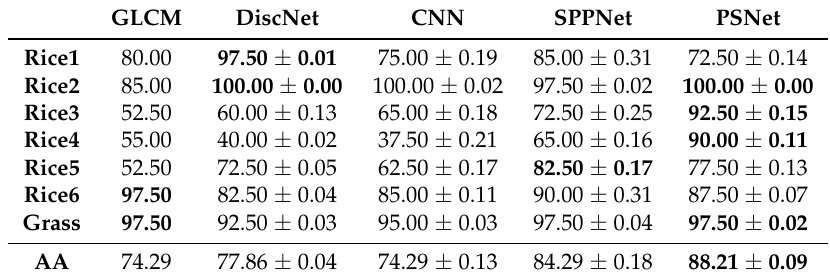
Table 6. Classification accuracy (%) on the Rice dataset. The bold number highlights the greatest classification accuracy per